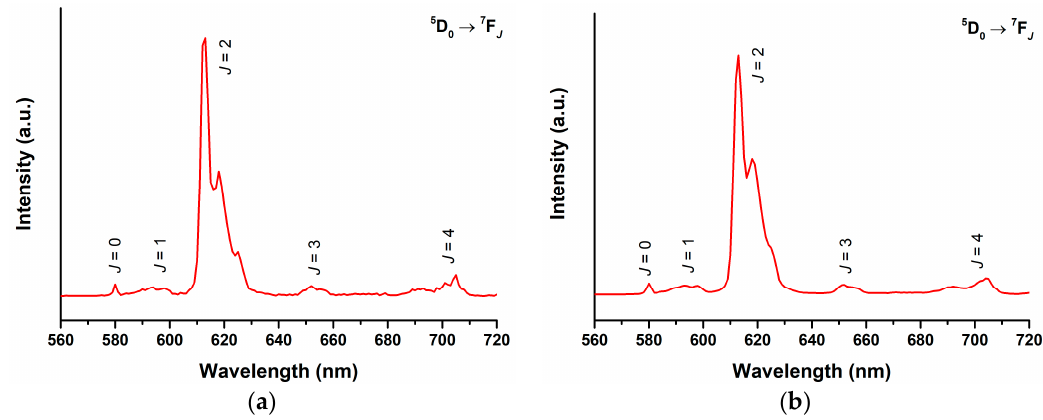
Figure 5. Photoluminescence spectra of ( a ) [Eu( pp -dbm-Cl 2 ) 3 phen] and ( b ) [Eu( mm -dbm-Cl 2 ) 3 phen] in THF, 10 µM. Measurement condition: λ ex = 360 nm, longpass filter = 380 nm.